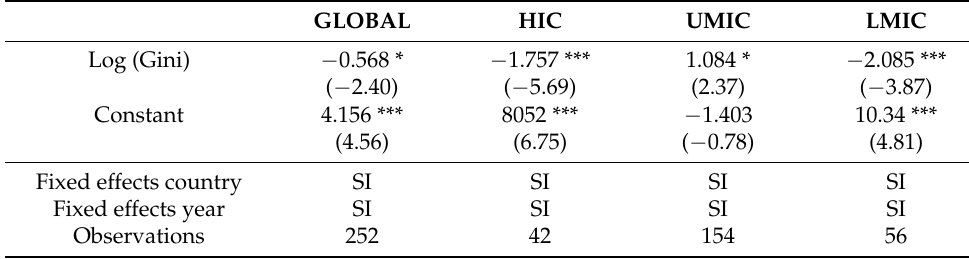
Table 3. Baseline regression of the GLS model, between inequality and the homicide rate.